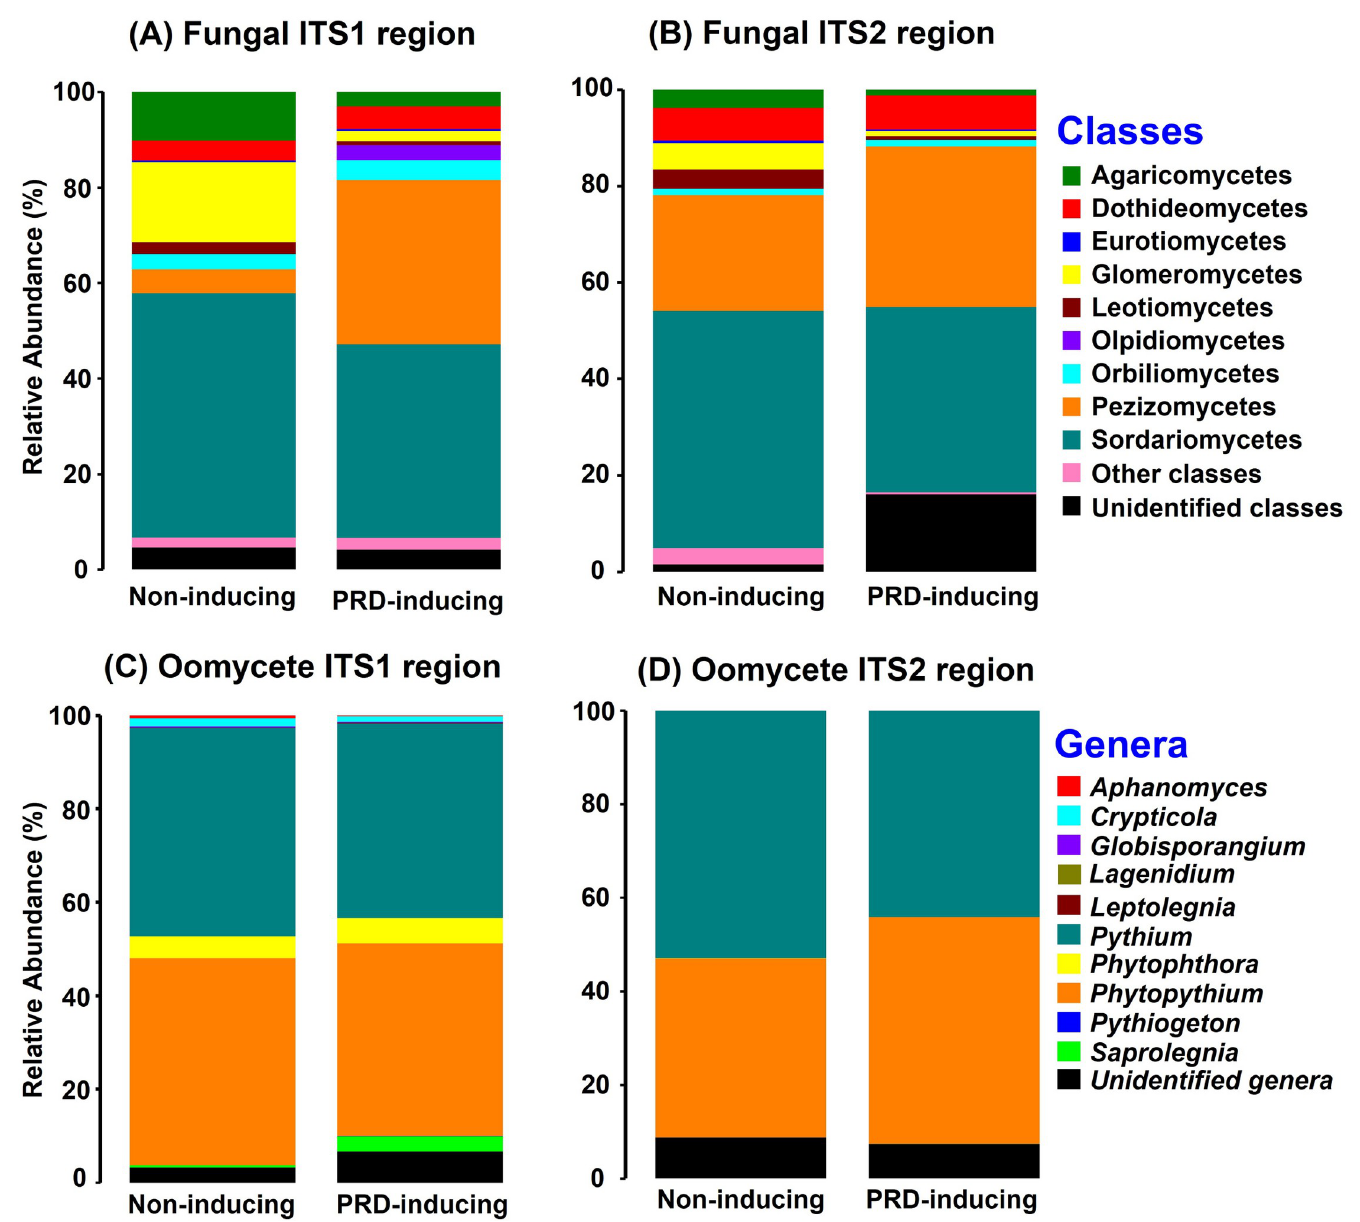
Fig 5. Composition of fungal and oomycete communities in peach roots from the six soils that were PRD-inducing and four that were non-inducing in the greenhouse bioassay. A and B , class-level relative abundances of fungal ASVs resolved from amplicons of ITS1 (primers ITS1f / ITS2) and ITS2 (primers fITS7 / ITS4) regions of the rRNA gene, respectively; and C and D , genus-level relative abundances of oomycete ASVs resolved from amplicons of ITS1 (primers ITS1oo-ITS7) and ITS2 (primers ITS3oo-ITS4) regions, respectively. The abundances were calculated after rarefication.